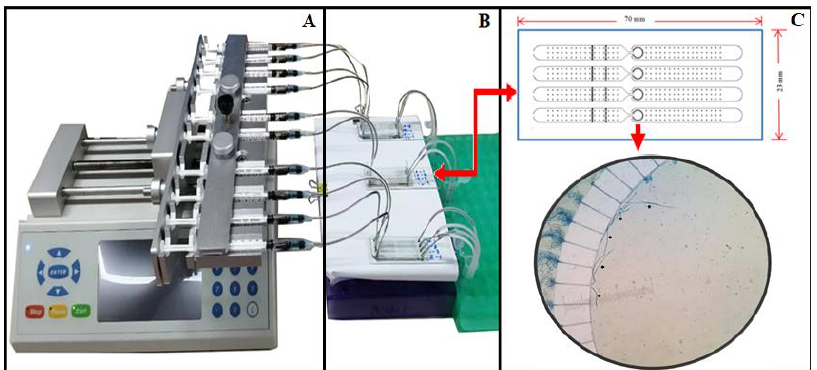
Figure 2. The microfluidic device for detection of microfilariae in canine blood samples. ( A ) The device consists of a sample injector, which includes an infusion pump ( B ) with 10 syringes with blunt-ended needle connected to the inlet of the microfluidic chips ( C ) The schematics of the microfluidic chips and the mf in the detection zone of the microfluidic chip.